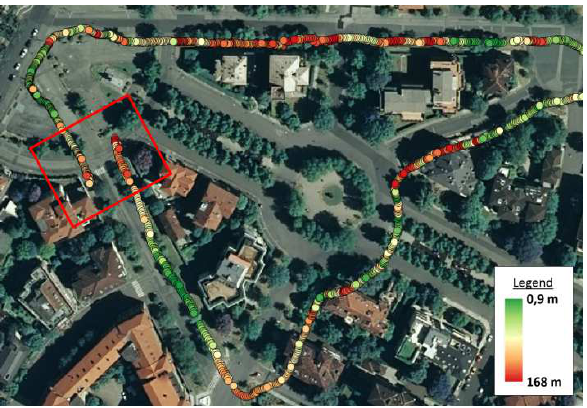
Figure 15. Difference between image coordinates measured by the U-blox 8T and the camera positions estimated by the software Agisoft Photoscan.